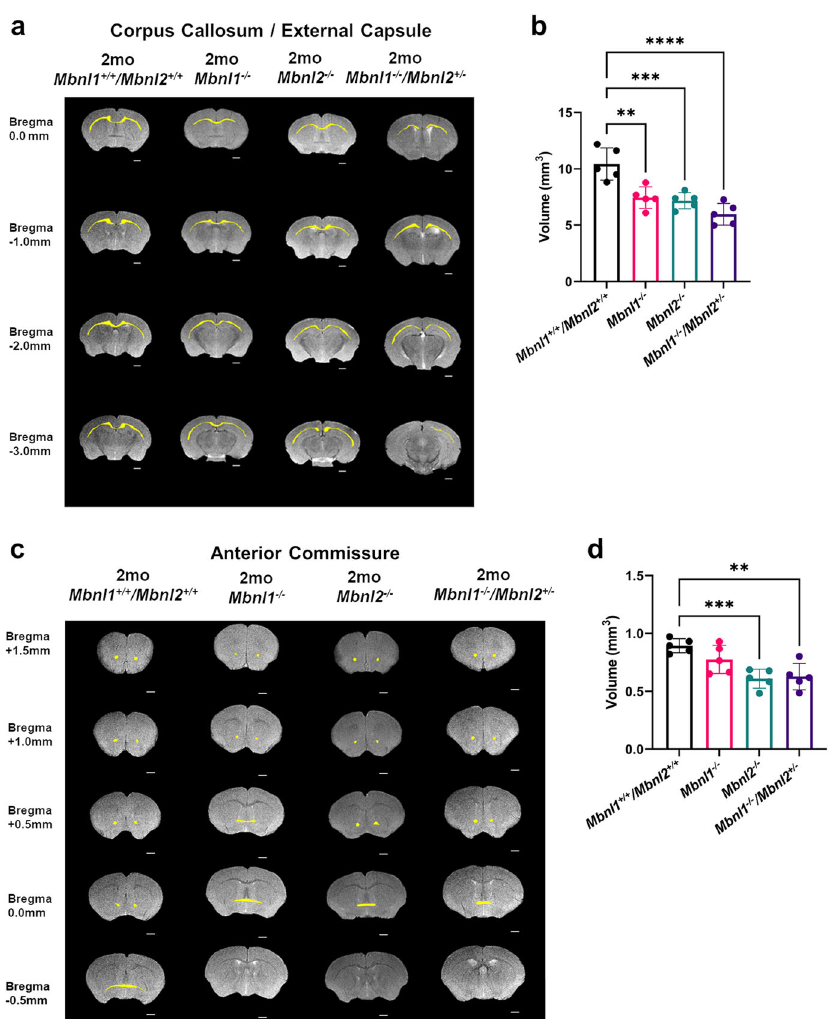
Fig. 6 White matter regional volume decreases in 2mo Mbnl1 − / − , Mbnl2 − / − , and Mbnl1 − / − /Mbnl2 + / − mice. a Representative axial brain slices from FSE T2w MRI scans with the corpus callosum/external capsule volumes overlaid in yellow. b Corpus callosum/external capsule volume measurements (mean ± SD) are shown. c Representative axial brain slices from FSE T2w MRI scans with the anterior commissure volumes overlaid in yellow. d Anterior commissure volume measurements (mean ± SD) are shown. Scale bar in 2D axial images denotes 1 mm. Error bars are standard deviations (SD). In all cases, * p < 0.05, ** p < 0.01, *** p < 0.001, and **** p <